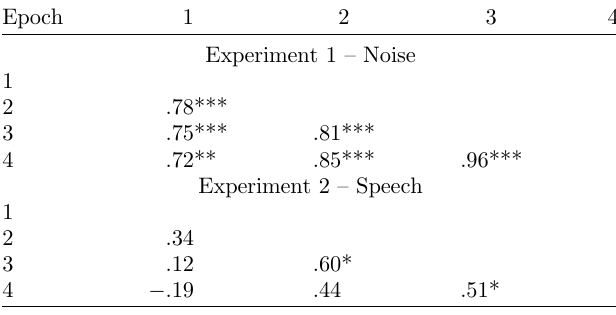
Table 1. Pearson correlation coef fi cients between all pairs of epoch for Experiment 1 (top) and Experiment 2